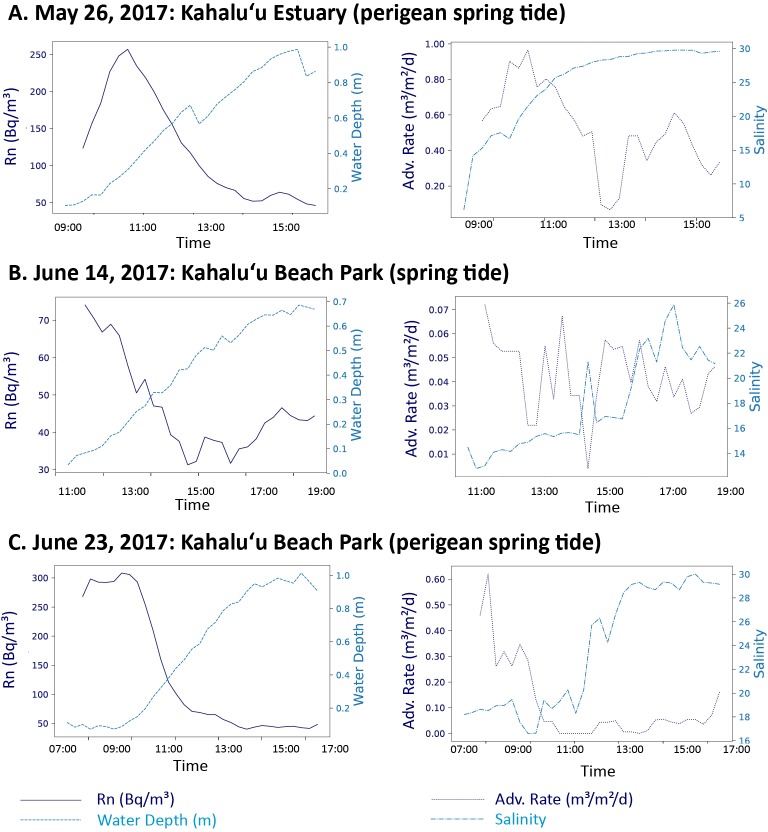
Radon time series.Radon (dark blue, in Bq/m3) and water depth (light blue, in m), and three-point running average advection rates (m3/m2/d) and salinity time series from low to high tide. Results from (A) May 26, 2017 (perigean spring tide, tidal range = 0.09 to 0.99 m) from Kahaluʻu estuary, (B) June 14, 2017 (spring tide, tidal range = 0.03 to 0.69 m) from Kahaluʻu Beach Park, (C) June 23, 2017 (perigean spring tide, tidal range = 0.02 to 1.01 m) from the same location at Kahaluʻu Beach Park.